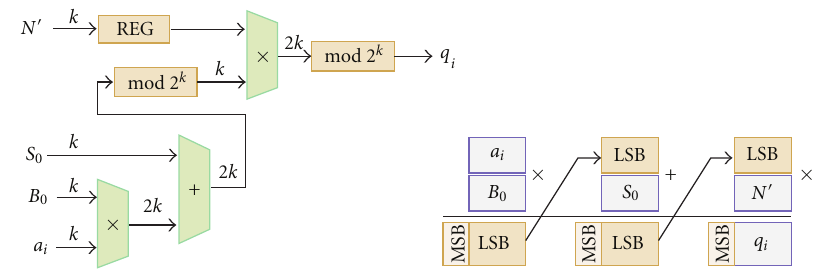
Figure 5: Internal architecture of the quotient block.